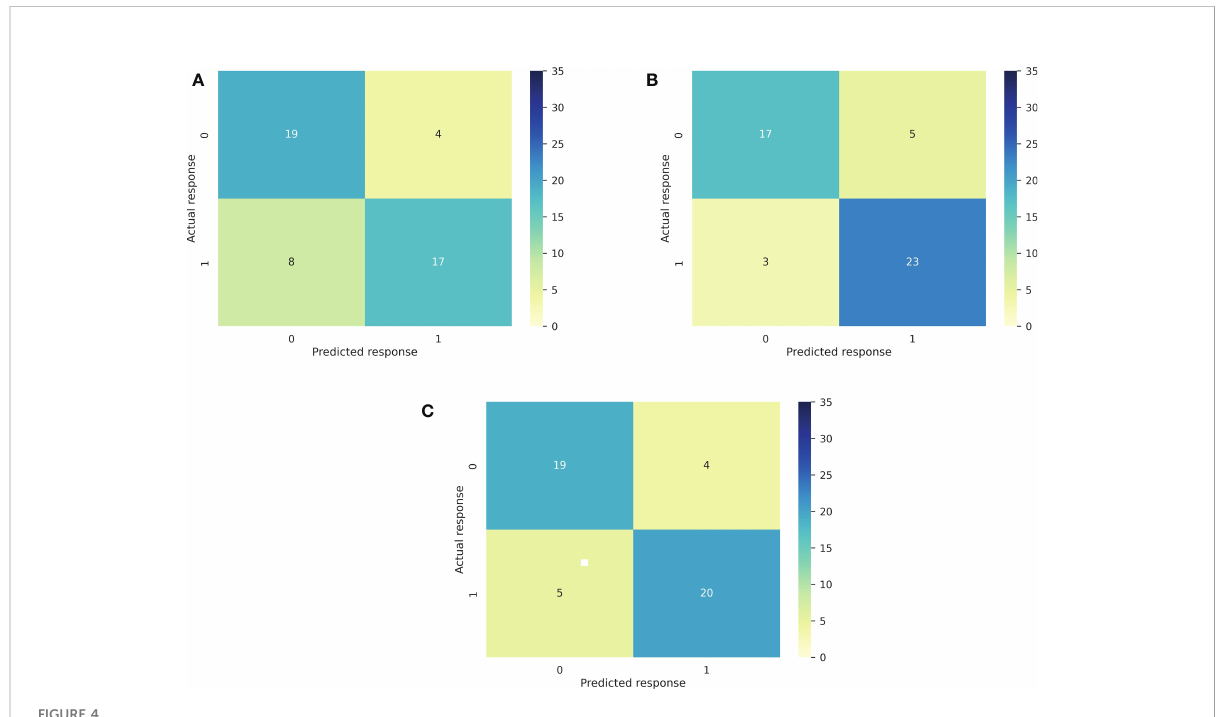
FIGURE 4 Confusion Matrixes for the CB model for main outcomes: DCR (A) , OS6 (B) , and TTF3 (C)